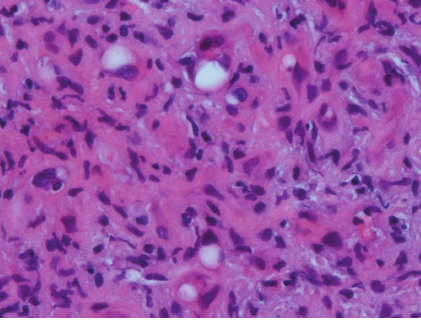
Figure 2: Liver biopsy showing scattered epitheliod cells. The tumor cells were stained positive for CD